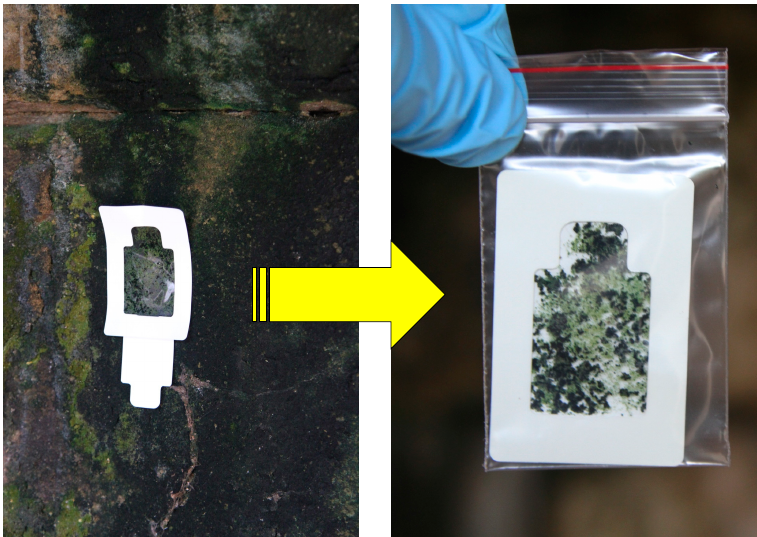
Figure 3. The adhesive sampling device in a slightly different configuration from that shown in Figure 2 used for sampling the surface colonizers on sandstone wall of Angkor temple in Cambodia and then transferred into a sterile plastic bag ready for preservation and transportation.